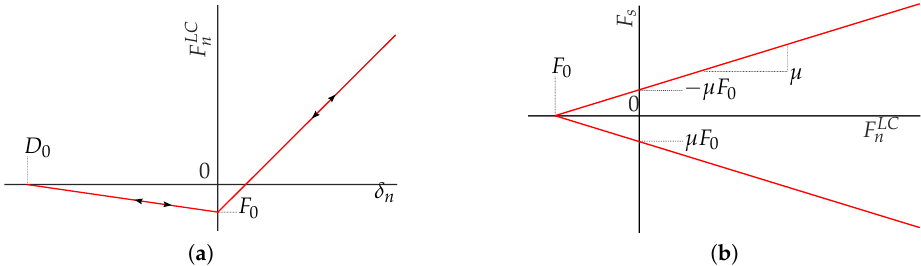
Figure 8. Force-deformation behaviour of the linear cohesive contact model (adapted from [82]). Reproduced with permission from Physical Review E; published by American Physical Society, 2007. ( a ) Normal force (damping omitted). ( b ) Coulomb limit of the shear